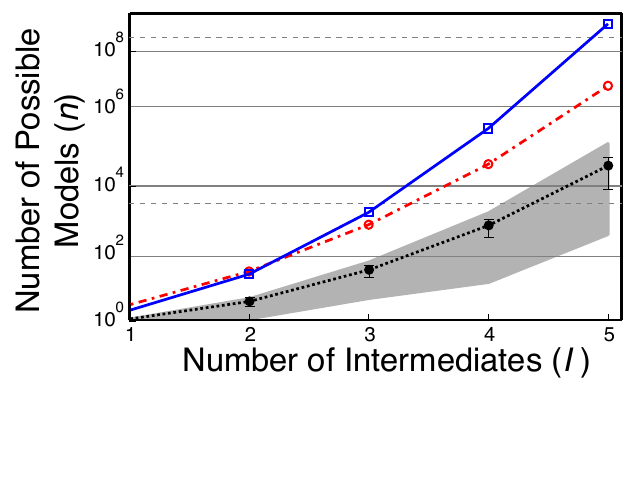
Figure 2. Illustration of the combinatorial explosion in the enumeration of all possible P matrices as a function of the number of intermediates I . In blue we plot n as given by equa- tion Equation 11 which we derive in the supplementary material. The red curve represents the number of models ( P matrices) that are tested when using the previous implementation of Kinfold by non-linear least squares optimization [9]. The black curve is the average num- ber of models that now need to test based on a sampling of 100 random data sets using our new approach. Error bars represent three standard deviations and the light gray shadow the maximum and minimum values of n for each I